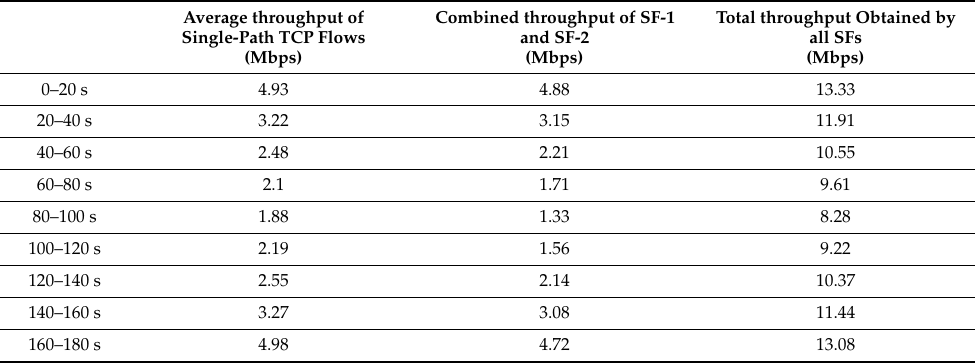
Table 1. In a scalable network scenario, the performance of D-OLIA in comparison with single-path TCP flows in terms of